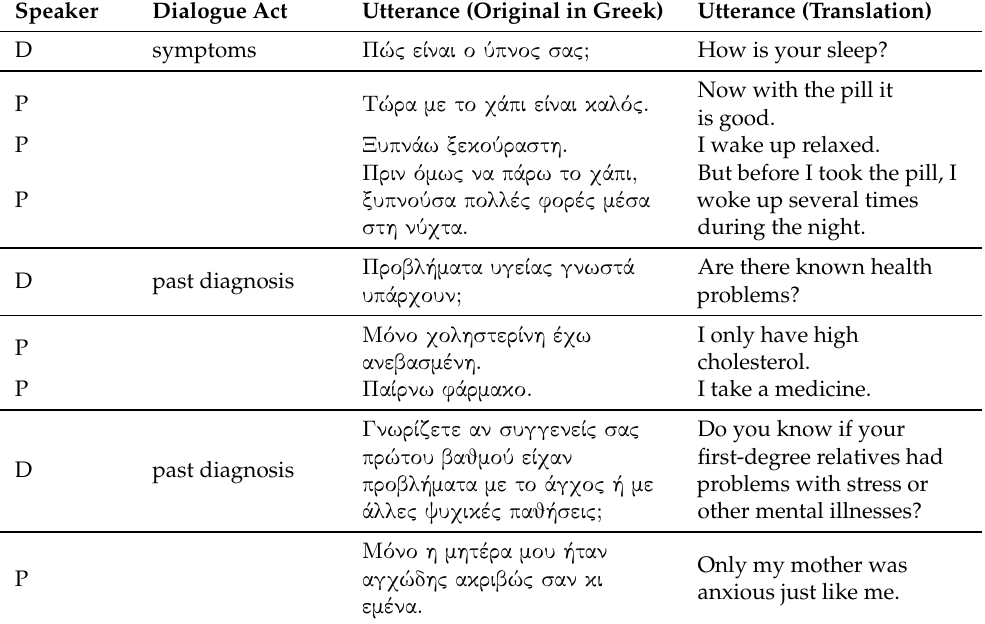
Table 1. An example of annotated interview between doctor (D) and patient (P). The original dialogue is in Greek, and it has been translated by software for illustrative purposes. Reprinted with permission from [14]. Copyright 2021 Association for Computing Machinery